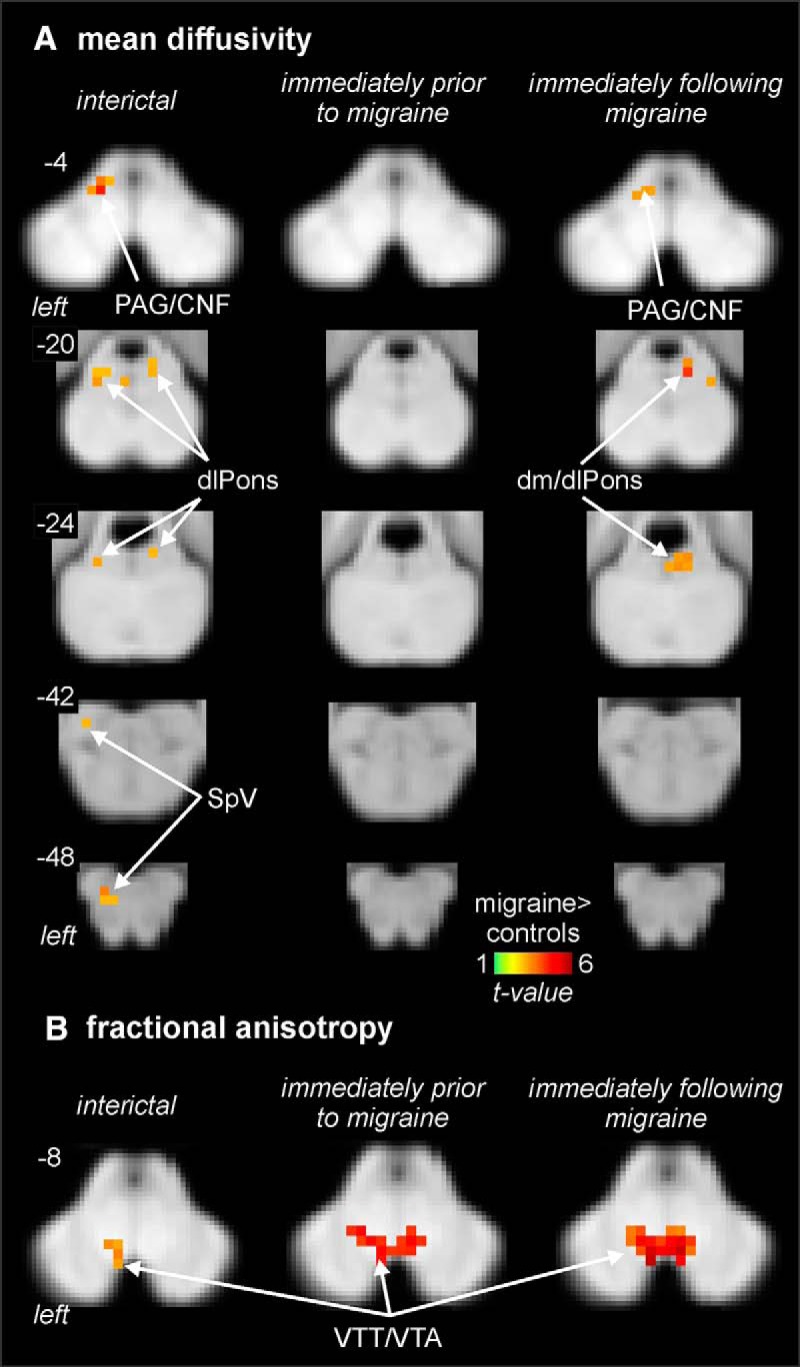

Regional MD (A) and FA differences (B) in migraineurs during the interictal (n = 31), immediately before migraine (n = 13), and immediately following a migraine (n = 15) compared with controls (n = 29). Significantly different clusters are overlaid onto axial brainstem template images and significant increases in migraineurs are represented by a t value with a hot color scale. Slice locations are indicated at the upper left of each axial slice in MNI space. Compared to controls, migraineurs have increased MD during the interictal and immediately following migraine periods in the region of the left SpV, left and right dlPons, and in the region encompassing the PAG/CNF. In addition, migraineurs display an increase in FA in the region of the VTT/VTA during all three phases compared with controls.